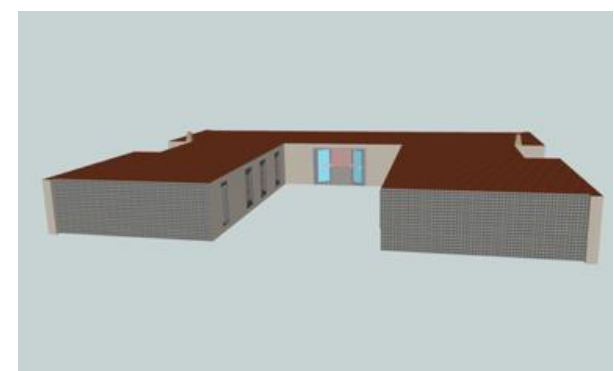
Figure 8: Visualisation in FME Data Inspector